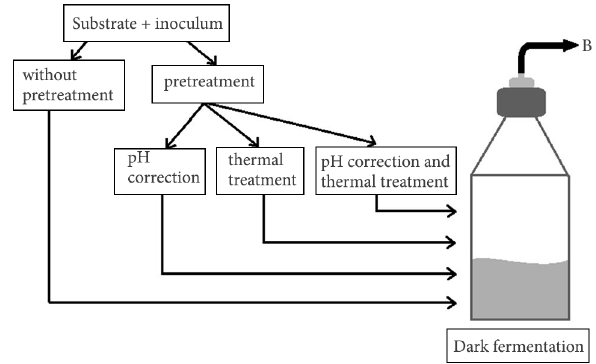
Figure 1. Schematic diagram of the